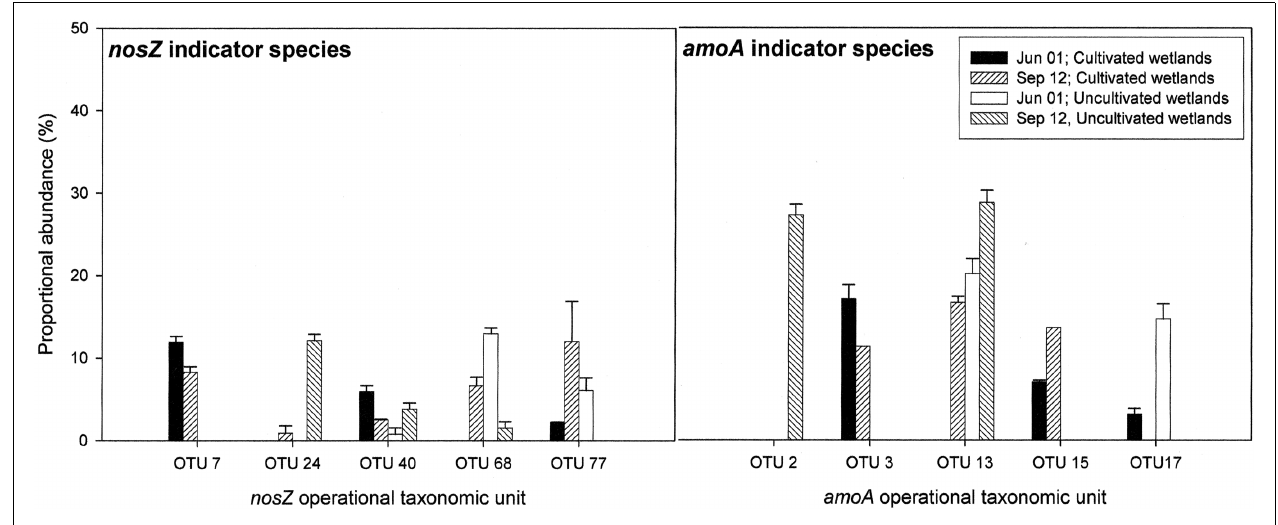
FIGURE 5 | nosZ and amoA operational taxonomic units (as defined by RFLP) that differed significantly between land-use and time based on indicator species analysis ( P < 0.1). Results are means with SE ( n = 3). Proportional abundance is the percentage of recovered clones with the defined RFLP.